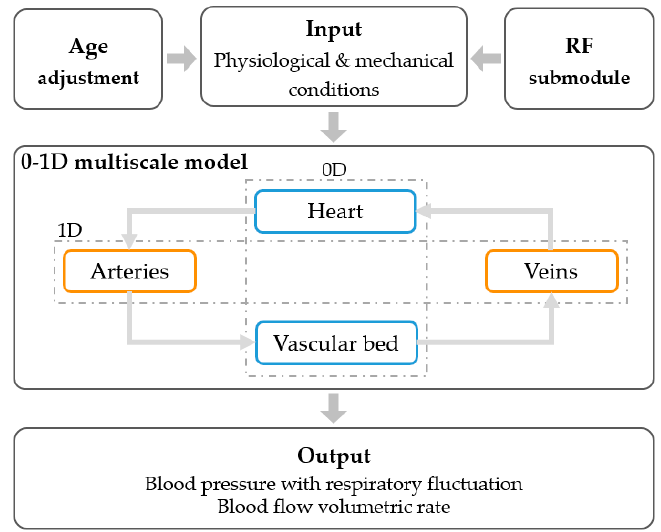
Figure 1. Flowchart of the 0-1D multiscale hemodynamic modeling with consideration of RF. The physiological and mechanical conditions associated with RF effect and age adjustment are incorpo- rated into a 0-1D multiscale model.